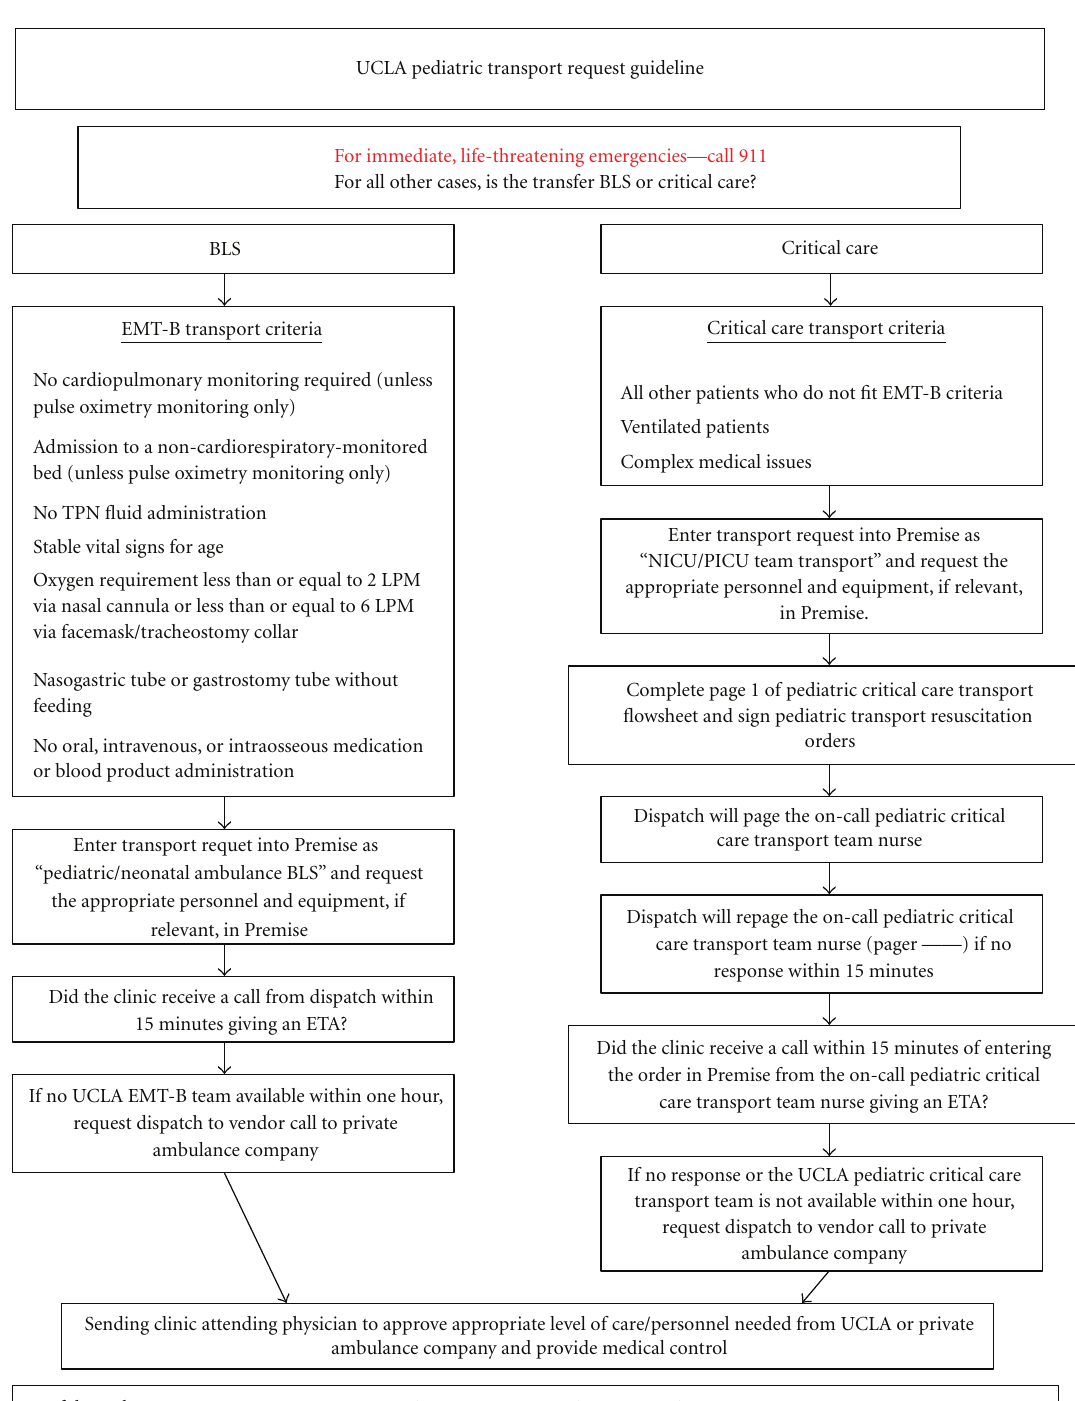
Figure 1: UCLA algorithm for transport of pediatric patients from medical o ffi ces to a higher level of care.